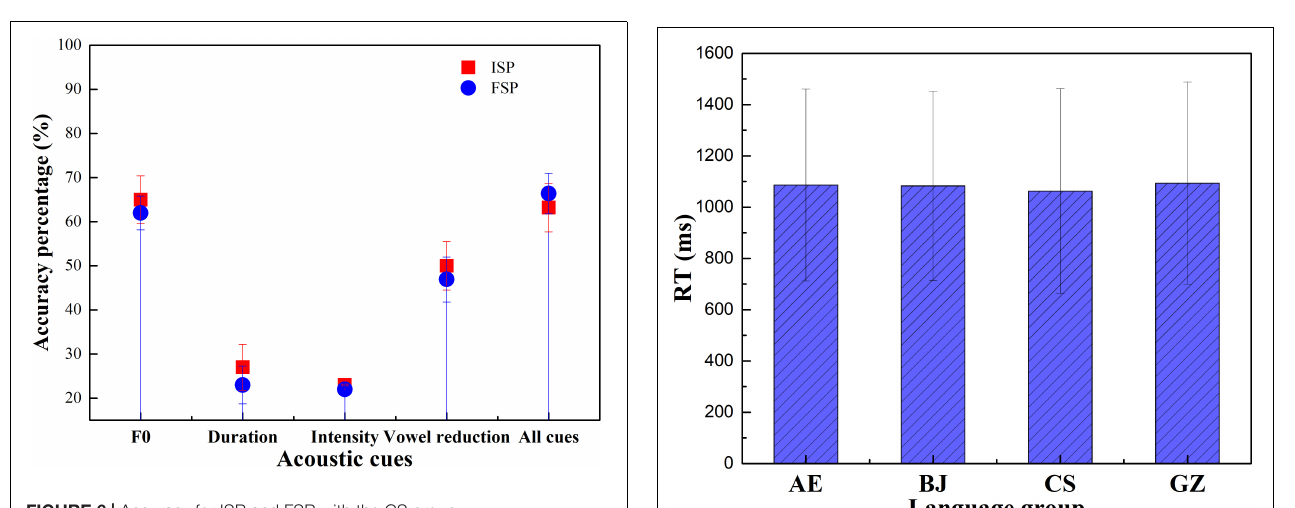
FIGURE 6 | Accuracy for ISP and FSP with the CS group.